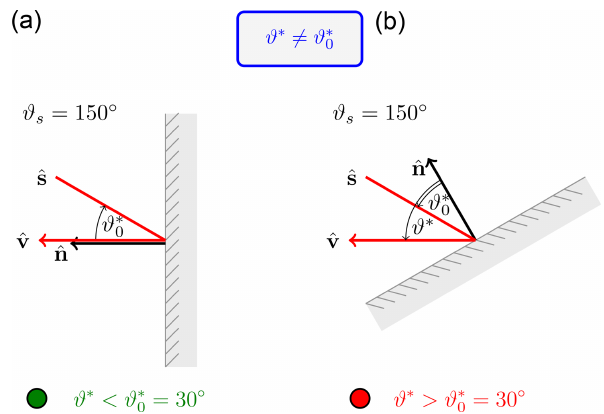
Figure 9. Two observation geometries with the same scattering angle ϑ s = 150 ◦ and the same local illumination angle ϑ ∗ (a) Steep viewing direction perpendicular (ϑ ∗ = 0 ◦ ) to the cloud surface. (b) Oblique viewing perspective (ϑ ∗ = 60 ◦ )